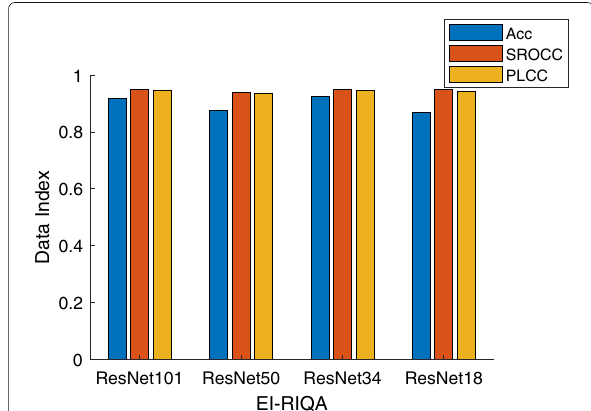
Fig. 5 Comparison histogram of VGGNet degrading results in LIVE